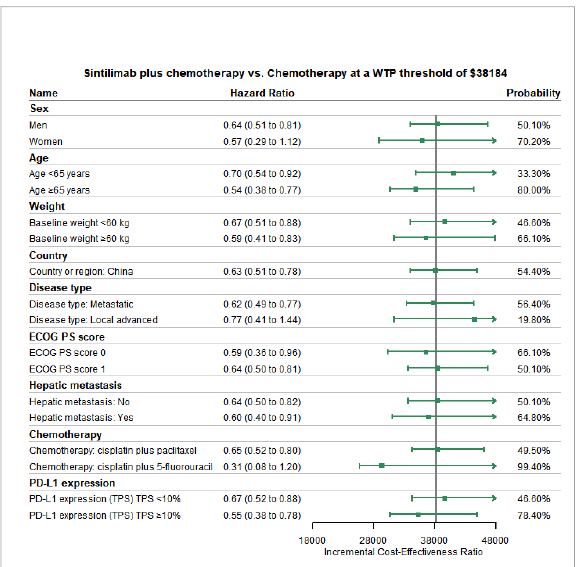
FIGURE 4 Subgroup Analysis Results of Incremental Cost-effectiveness Ratios (ICERs) and Probabilities of Cost-effectiveness Obtained by Varying the Hazard Ratios (HRs) for Overall Survival. ECOG PS, Eastern Cooperative Oncology Group performance status score; TPS, tumor cell proportion